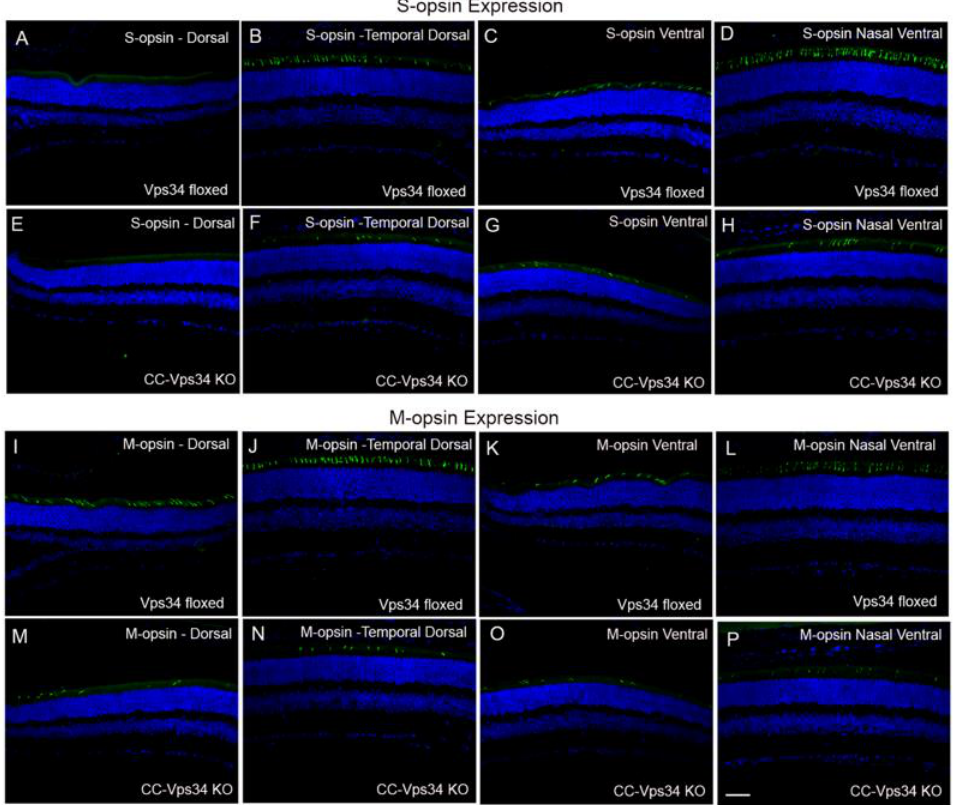
Figure 4. Regional distribution of S-opsin- and M-opsin-positive cones in Vps34 floxed and CC-Vps34 KO mice. The difference in expression of S-opsin (S-opsin-positive cones) ( A – H ) and M-opsin (M-opsin-positive cones) ( I – P ) in dorsal, temporal dorsal, ventral, and nasal ventral areas of the retina from 6-week-old Vps34-floxed and CC-Vps34 KO mice. The images shown are representative of six retinas examined from Vps34-floxed and CC-Vps34 KO mice. Scale bar = 50 μm.